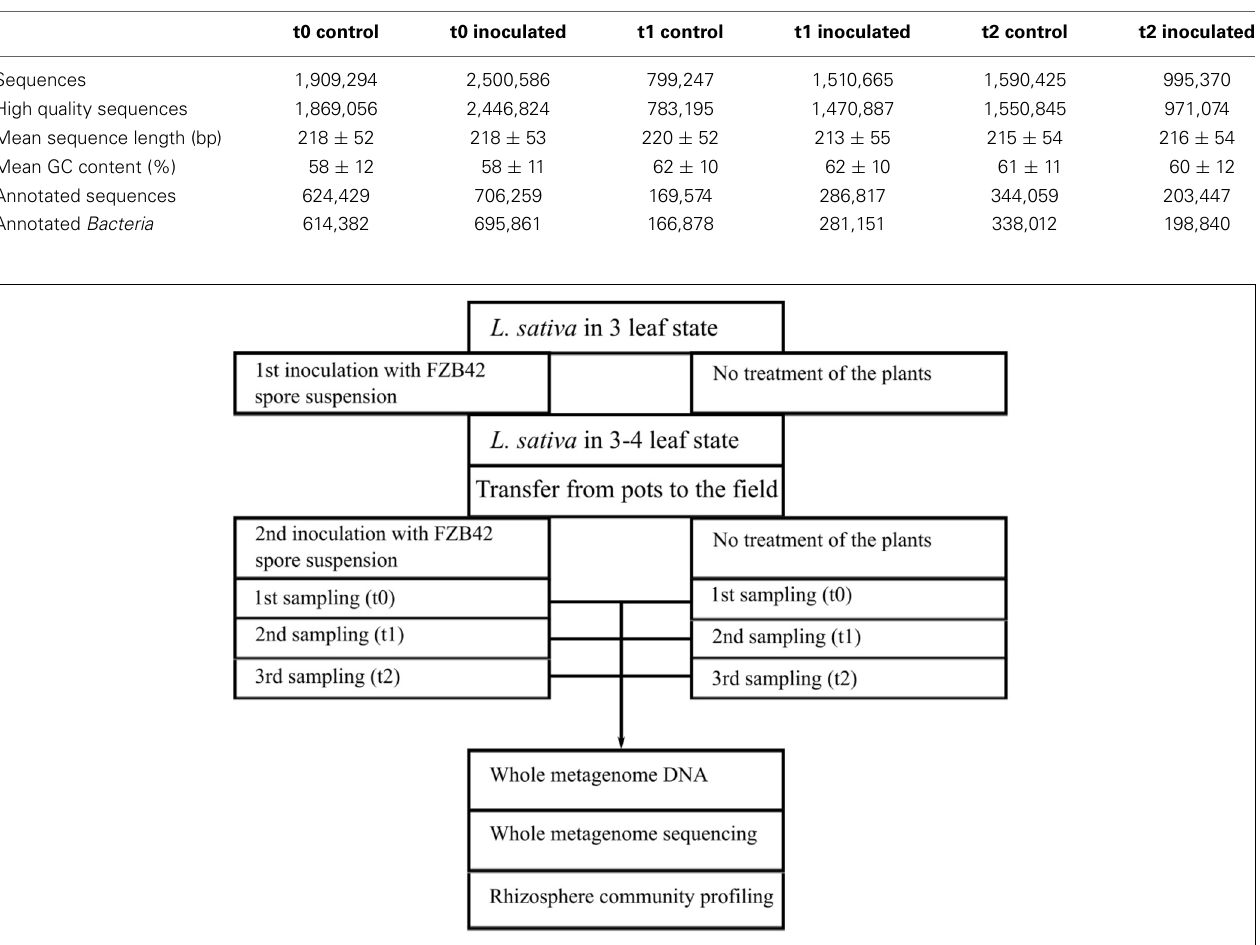
non-treated plants. Rhizosphere samples were used for whole community DNA extraction and subsequently for metagenome sequencing.